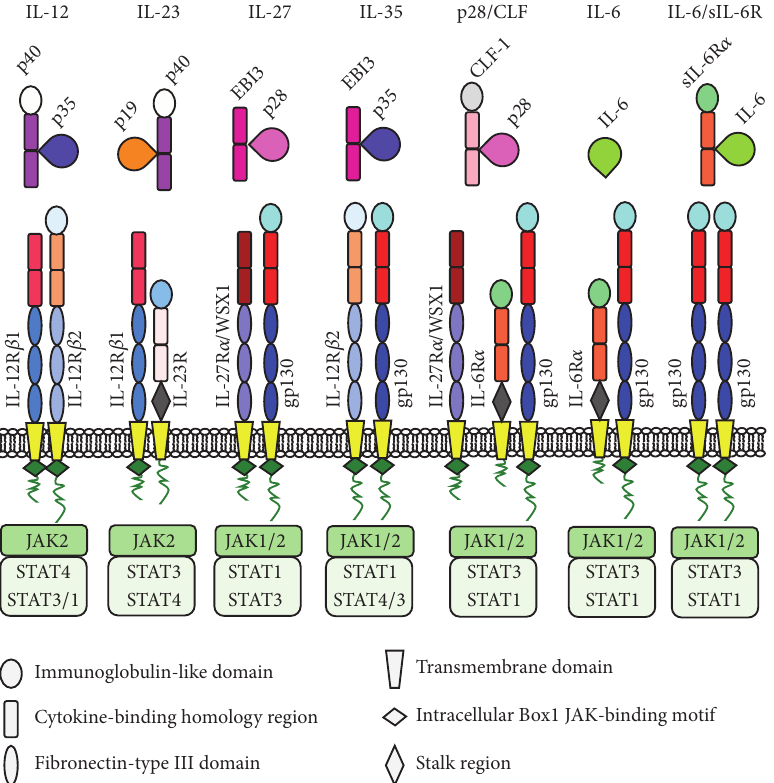
Figure 1: Examples of cytokine and cytokine receptor chain sharing among members of the IL-12 and IL-6 cytokine families. The main signaling pathways are also